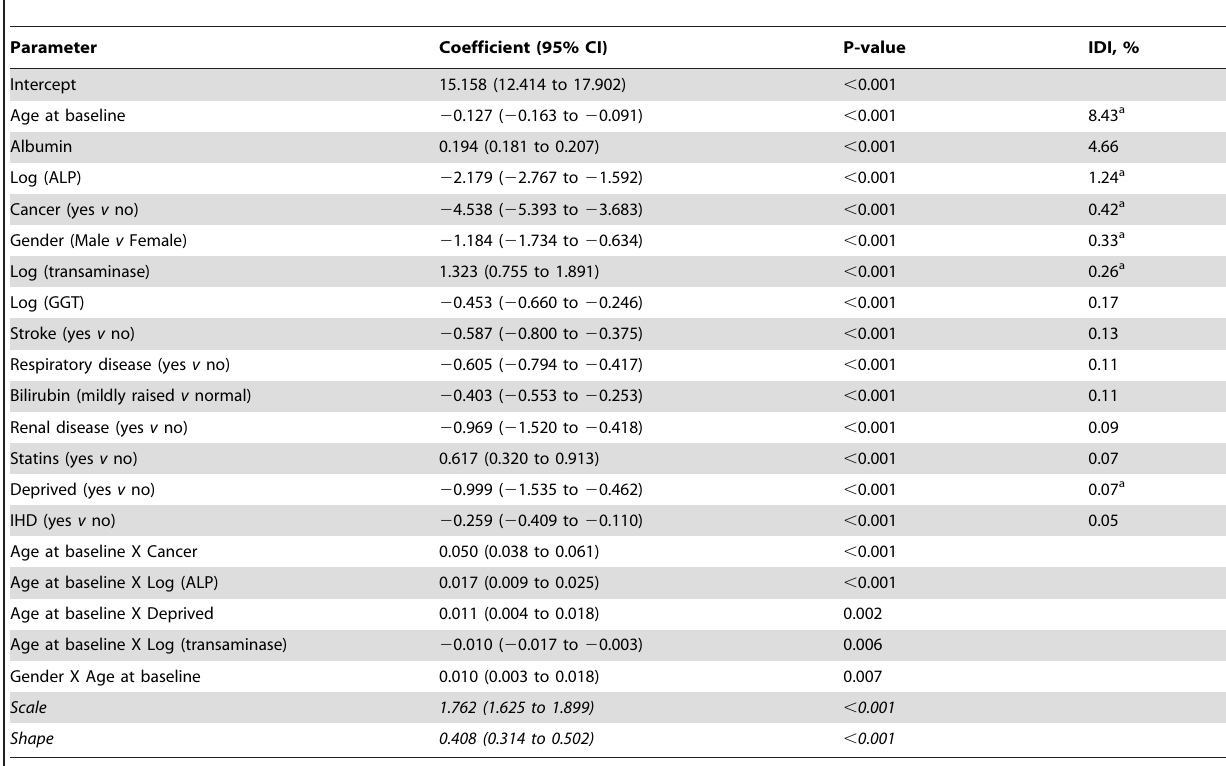
Table 3. Parameter estimates of the final generalised gamma model predicting risk of all-cause mortality within 1 year of initial liver function tests.